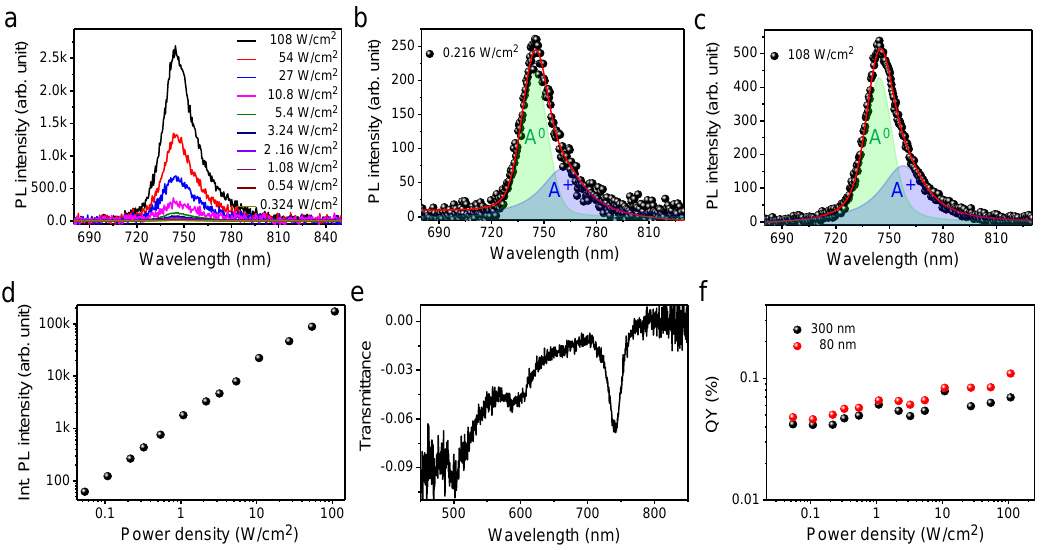
Figure 5. ( a ) Confocal PL spectra of the exfoliated 1L-WSe 2 on a quartz substrate with various laser intensities. Deconvoluted PL spectra of the exfoliated 1L-WSe 2 at ( b ) 0.216 W/cm 2 and ( c ) 108 W/cm 2 . ( d ) Integrated PL intensity of 1L-WSe 2 as a function of laser intensity. ( e ) Representative transmittance spectra of 1L-WSe 2 . ( f ) Plot of the QYs of 1L-WSe 2 as a function of laser intensity, estimated using 80- and 300-nm-thick reference specimens.